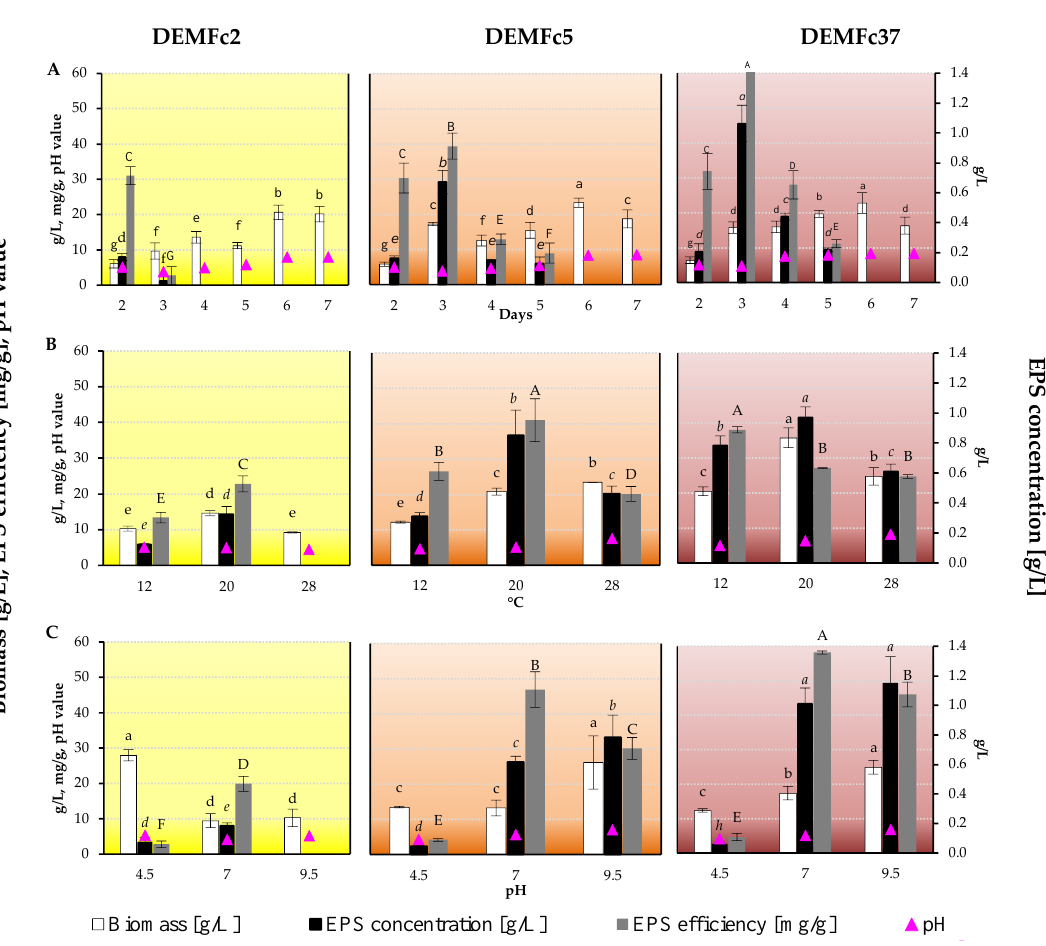
Figure 4. Fungal dry biomass [g / L], EPS yield: EPS concentration [g / L], EPS concentration converted into fungal biomass dry weight [mg / g], and final pH of the post-culture liquid at di ff erent condition of: ( A ) time of incubation, ( B ) temperature of incubation, ( C ) medium initial pH value of F. culmorum cultures. Statistical data analysis: one-way ANOVA with post hoc Tukey’s HSD test, p < 0.05. Mean values labeled with the same letter within the same series are not significantly di ff erent ( p > 0.05). Standard deviations are shown as deviation bars ( n = 9).